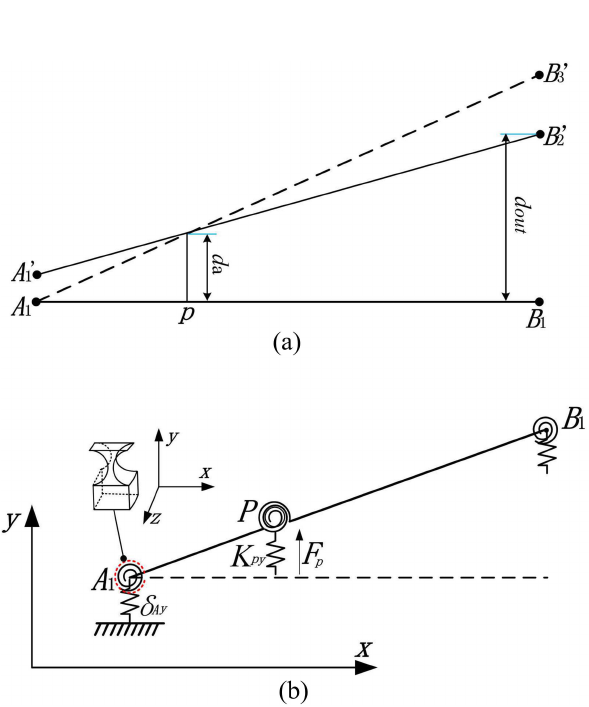
Figure 10. Lever amplifier mechanism. (a) Bending schematic di- agram; (b) analysis